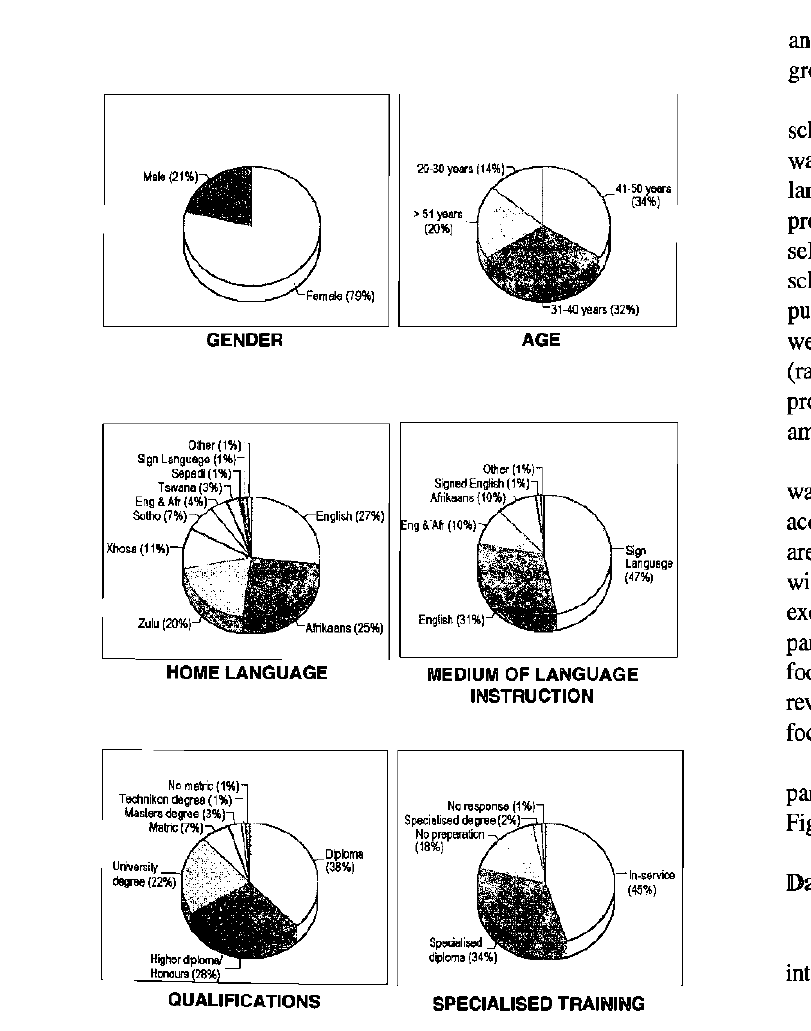
Figure 1: Description of participants in the question- naire survey